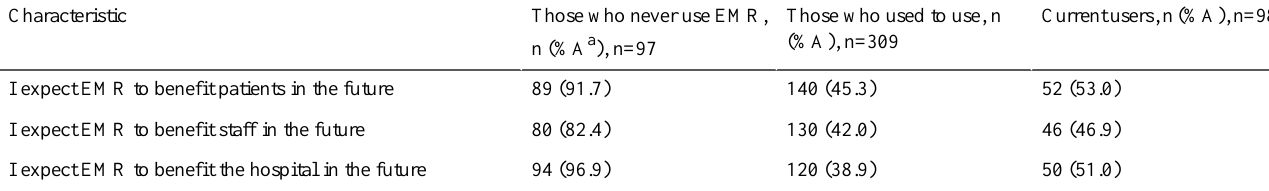
Table 6. Expectations of future benefits of EMR users and non-users